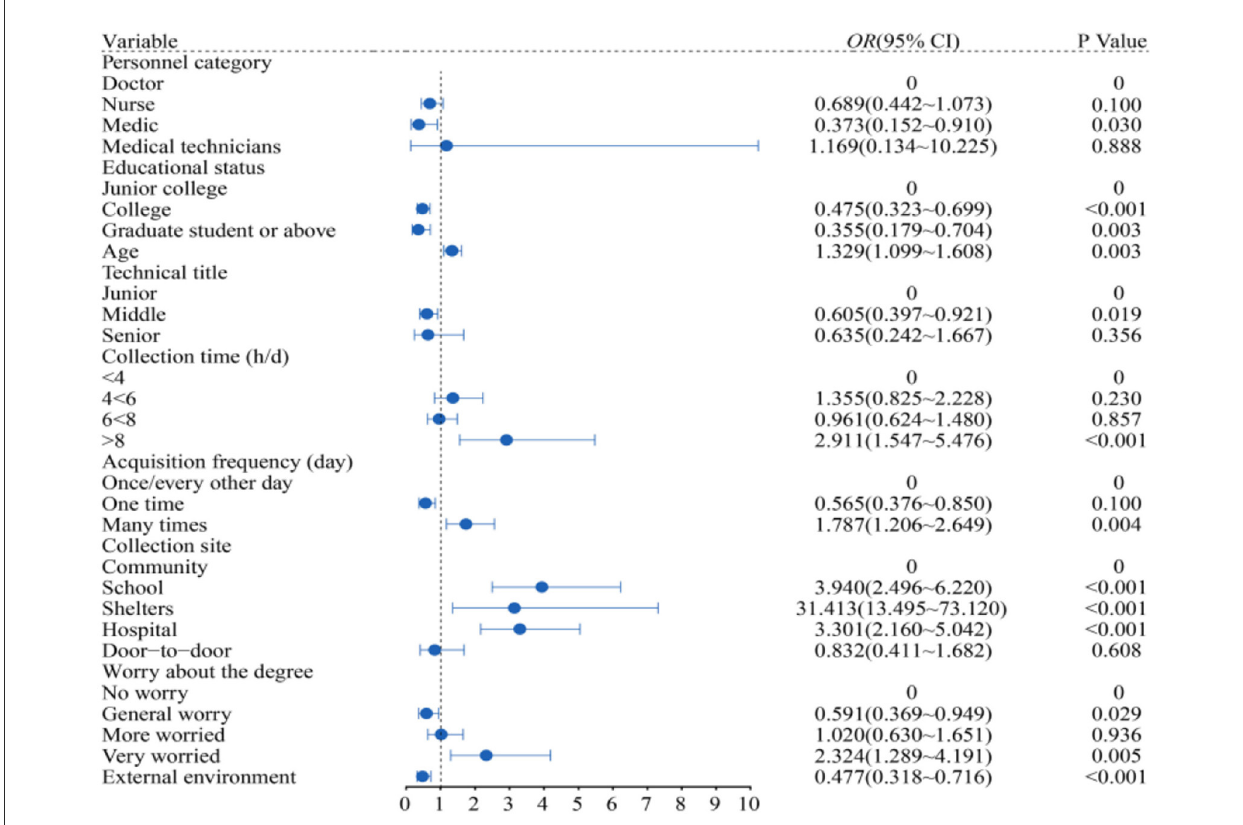
FIGURE1 Results of binary logistic model to predict depression